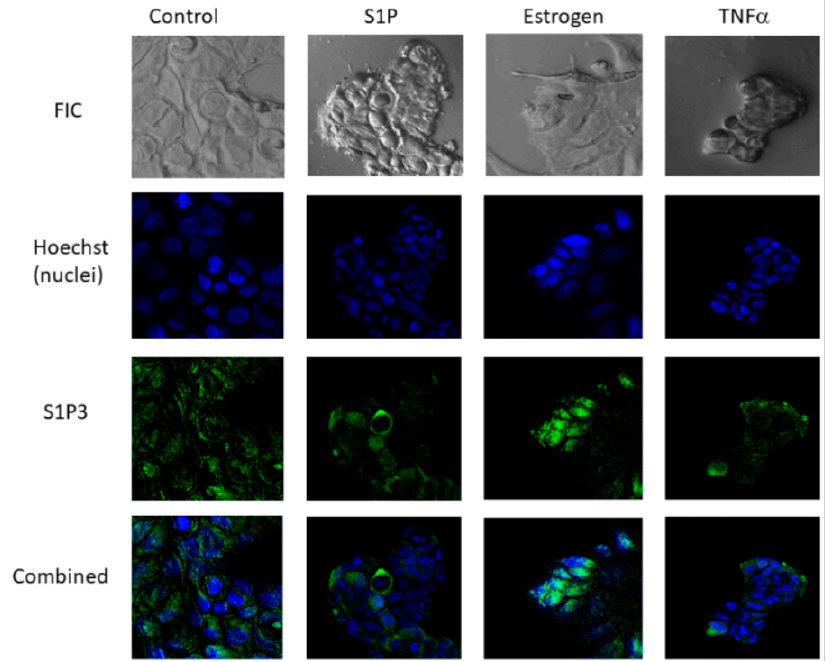
Figure 4. S1P3 intracellular localization was visualized using IF and confocal microscopy ( × 400) in parental MCF-7 cells treated with vehicle (control), 10 nM estrogen, 500 nM S1P, or 100 ng/mL TNF α for 3 h. Endogenous S1P3 protein (green) was visualized using Alexa 488-conjugated secondary antibodies. Representative images are shown; experiments were repeated three